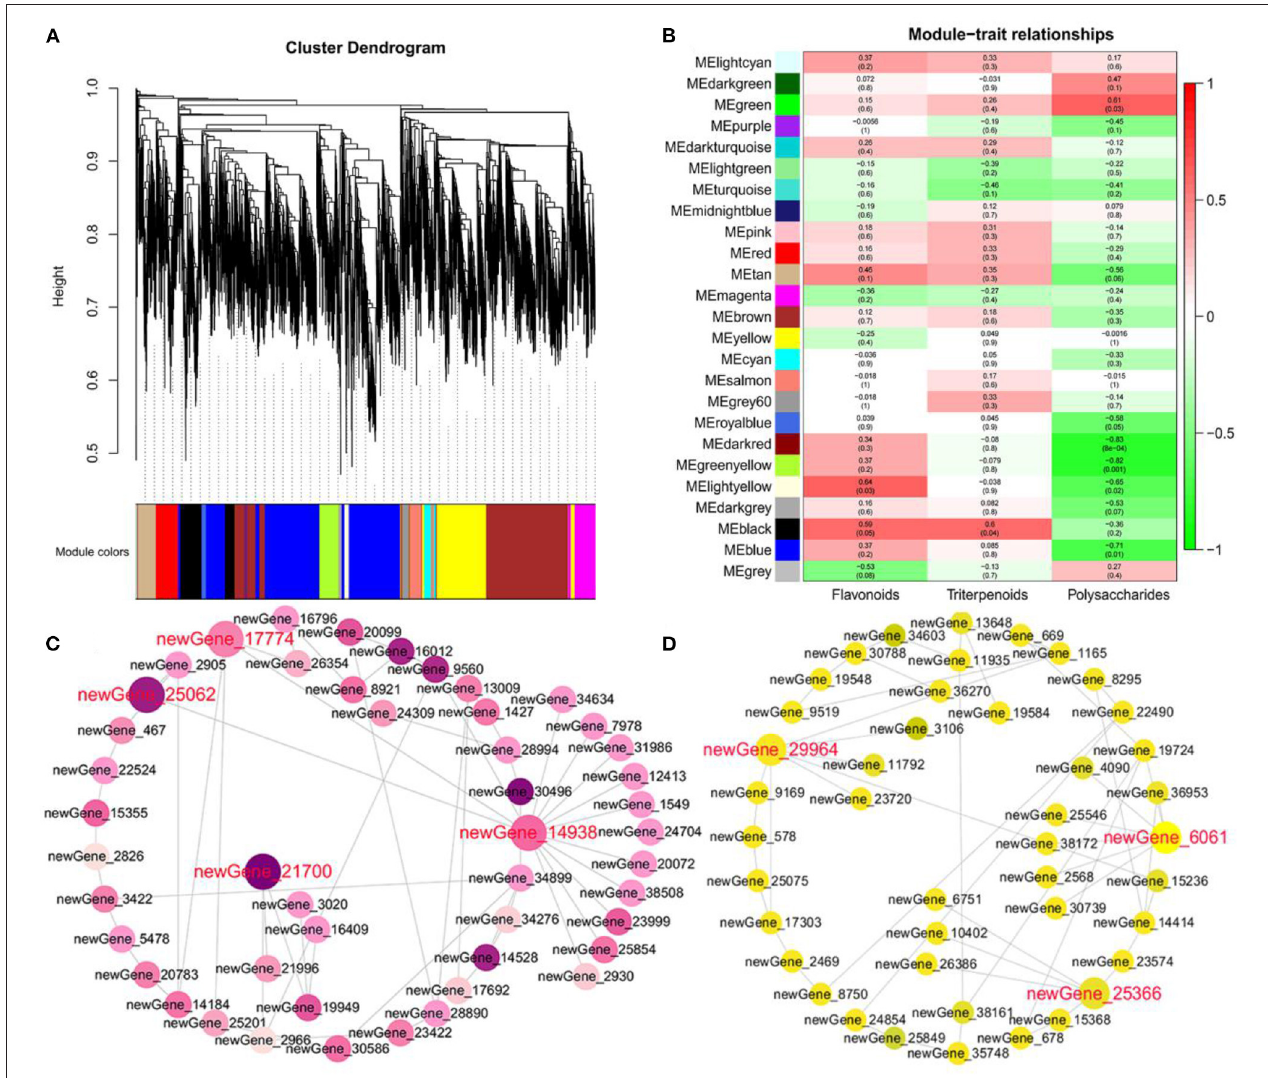
FIGURE 6 | Hub gene identification involved in hypoglycemic nutrient metabolites. (A) Tree diagram of all DEGs based on a value of dissimilarity measure (1-TOM). (B) Gene modules associated with the content of triterpenoids, polysaccharides, and flavonoids. (C) Coexpression network revealing the hub genes related to polysaccharides in the green module. (D) Coexpression network revealing the hub genes related to flavonoids in the light yellow module.